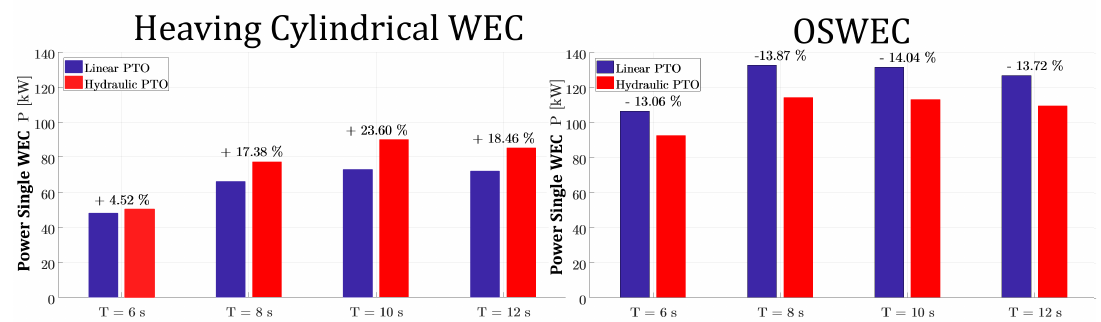
Figure 6. Bar chart showing the power output for one WEC with linear PTO system ( P l ) (purple) and hydraulic PTO system ( P h ) (red) with the percentage difference between the two. Results for the heaving cylindrical WEC shown on the left and for the OSWEC on the